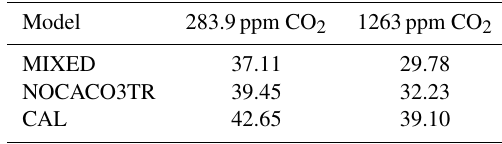
Table 2. Initial ocean nitrate inventory in